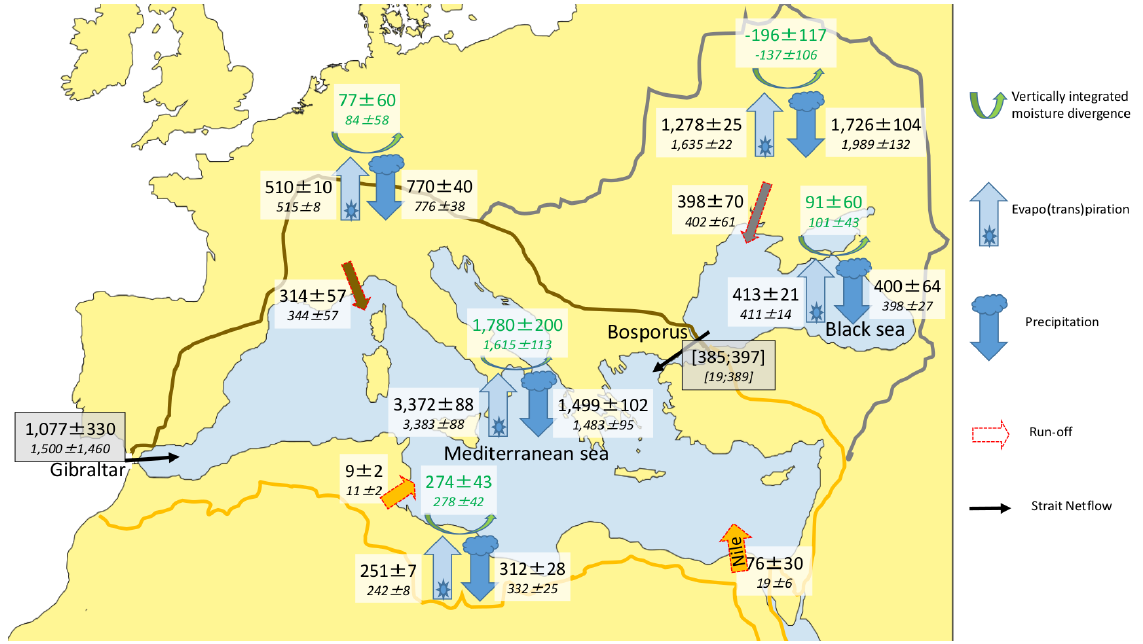
Figure 6. Mean annual fluxes (km 3 yr − 1 ) of the Mediterranean WC and associated uncertainties in SW (small font) and INT (large font) during the 2004–2009